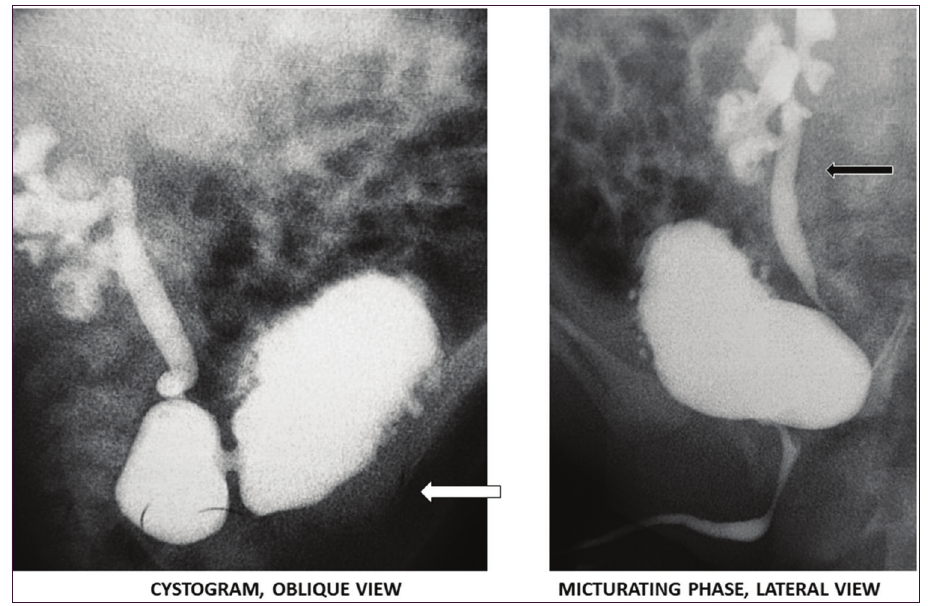
Figure 1: Micturating cystourethrogram pictures showing the retrovesical diverticulum (white arrow), Grade III vesicoureteral reflux (black arrow) with a normal posterior urethra patient presented with poor stream and